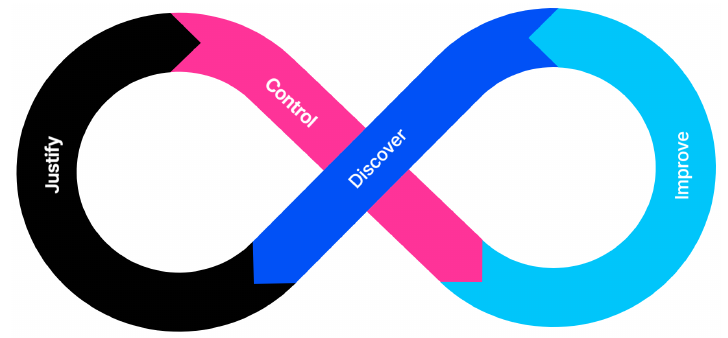
Figure 2. The need for